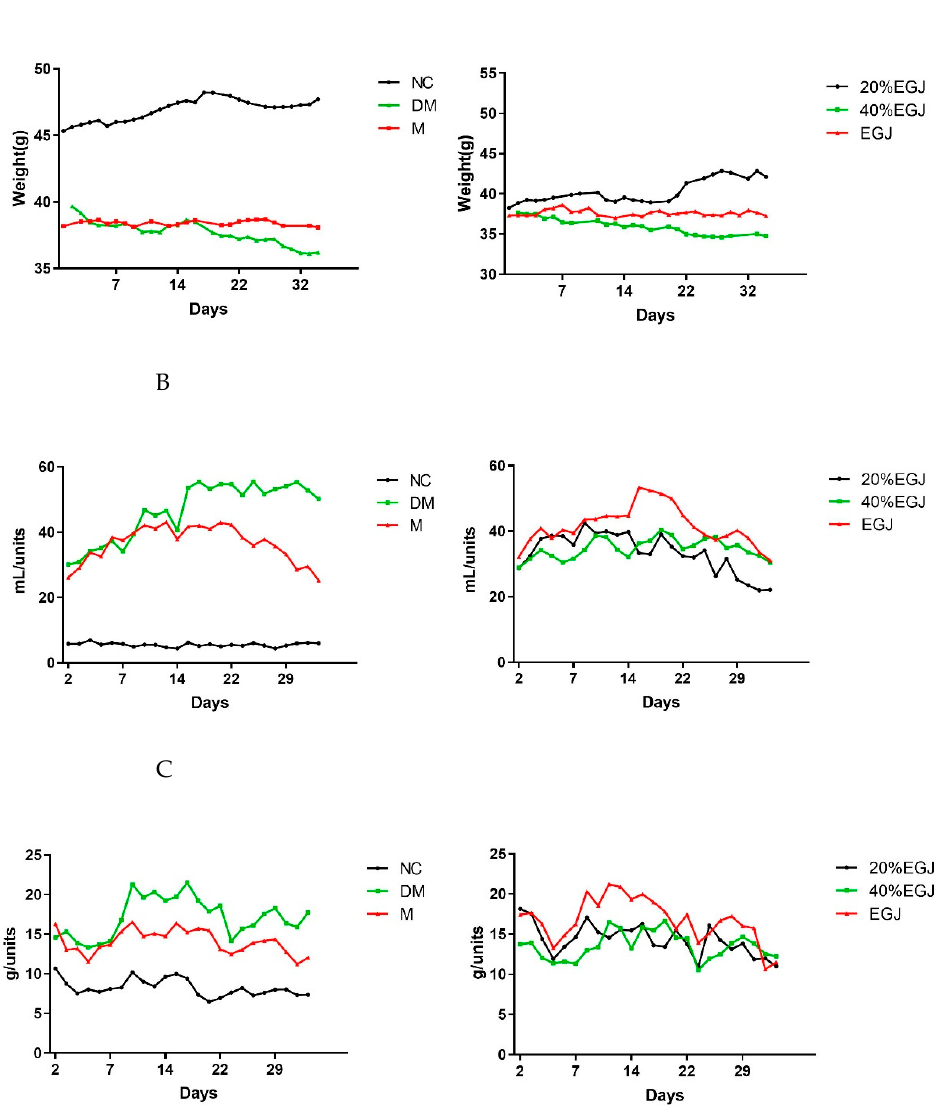
Figure 9. The changes of ( A ) the body weight ( B ) the water intake, and ( C ) the food intake. 3.4.2. Effects of the Crude EGJ, 20% EGJ, and 40% EGJ on the FBG, OGTT, and AUC As shown in Figure 10A, during the period of administration, the level of the FBG in the NC group was basically stable at the normal level ( ≤ 7.8 mmol/L). Compared to the NC group, the FBG in the other groups were significantly higher. The FBG in the DM group was the highest, indicating that the hyperglycemia symptoms were the most severe [27]. In the M group, the level of the FBG reached the highest level in the first week, and then decreased, indicating that the metformin could restore the FBG of the T2DM to fluctuate within the normal range. There was no significant difference between the 20% EGJ group and the EGJ, for which the FBG levels were separately 11.06 ± 2.62 and 17.33 ± 2.25 mmol/L at the fifth week. However, the 40% EGJ group did not show a significant downward trend. These results indicated that the metformin, 20% EGJ (geniposide), and EGJ could effectively alleviate the level of the FBG in the T2DM mice. The OGTT experiment was carried out two days before the end of the experiment. As shown in Figure 10B, the level of the blood glucose of the mice in each group increased after 15 min caused by the glucose intake on fasting. Except for the DM group, the level